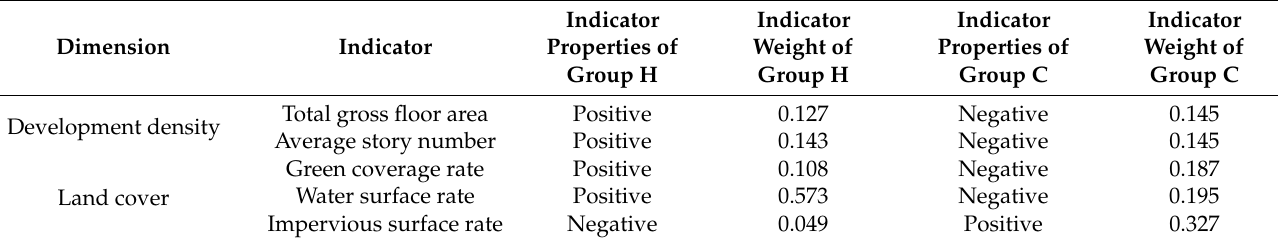
Table 4. Weighting of indicators for evaluating the morphological characteristics.